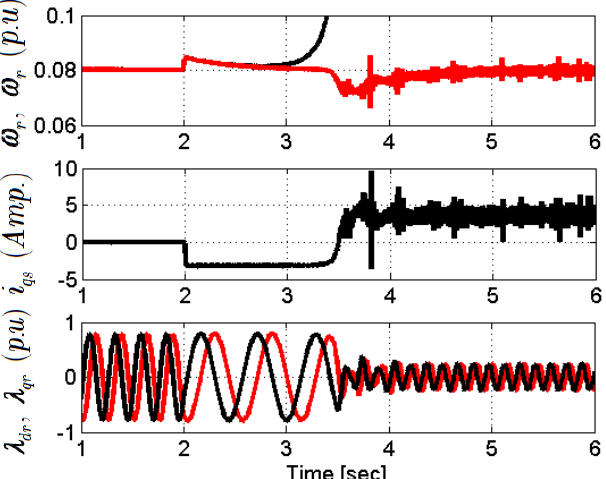
Figure 11. Simulation tests at a speed reference of 0.08 p.u (12.56 rad/s) with rated T L change of − 7 N.m at t = 2 s. Unstable AFO ( K 1 = K 2 = 0).